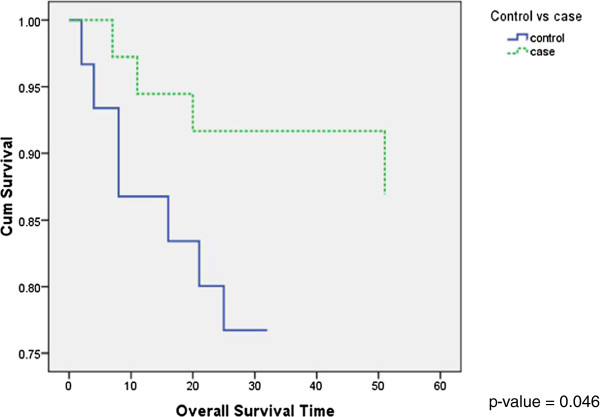
Kaplan Meier overall survival curves for the two groups (Cases vs. Controls).